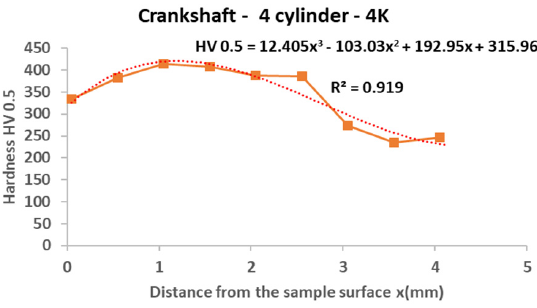
Figure 22. Regression analysis for a 3rd − order polynomial for crankshaft values on 4th cylinder.